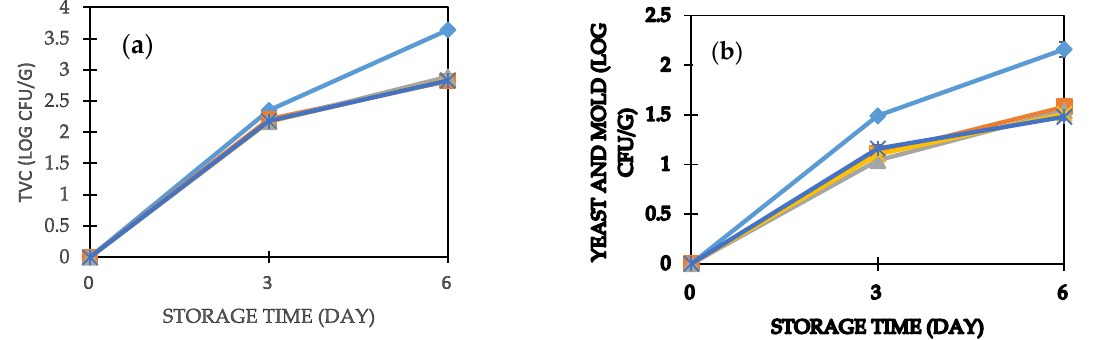
Figure 3. Changes in: ( a ) total viable counts (TVC); ( b ) yeast and molds in bread during storage. The bars indicate standard errors of means. White bread ( ♦ ); 20% OFSP bread ( ■ ); 30% OFSP bread ( ▲ ); 40% OFSP bread ( ∗ ); 50% OFSP bread ( ∗ ).